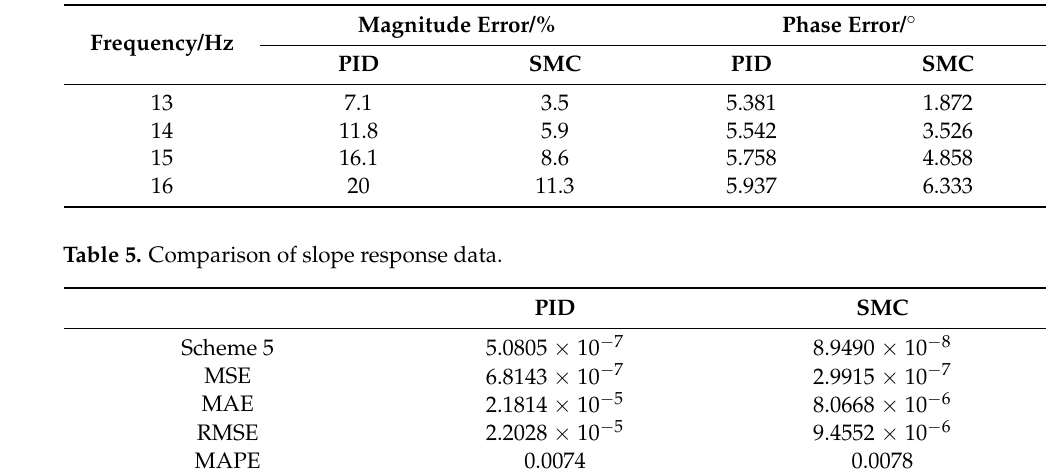
Table 4. Comparison of sine response data.